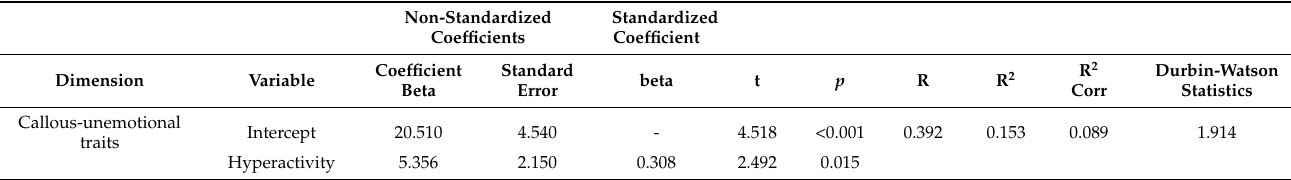
Table 2. Overview of the multiple regression analyses with callous-unemotional overall score and cognitive empathy scores at age 14 as dependent variables, and parents’ ratings of children’s strengths and difficulties (SDQ) and objectively assessed sleep efficiency at age five years as independent variables.